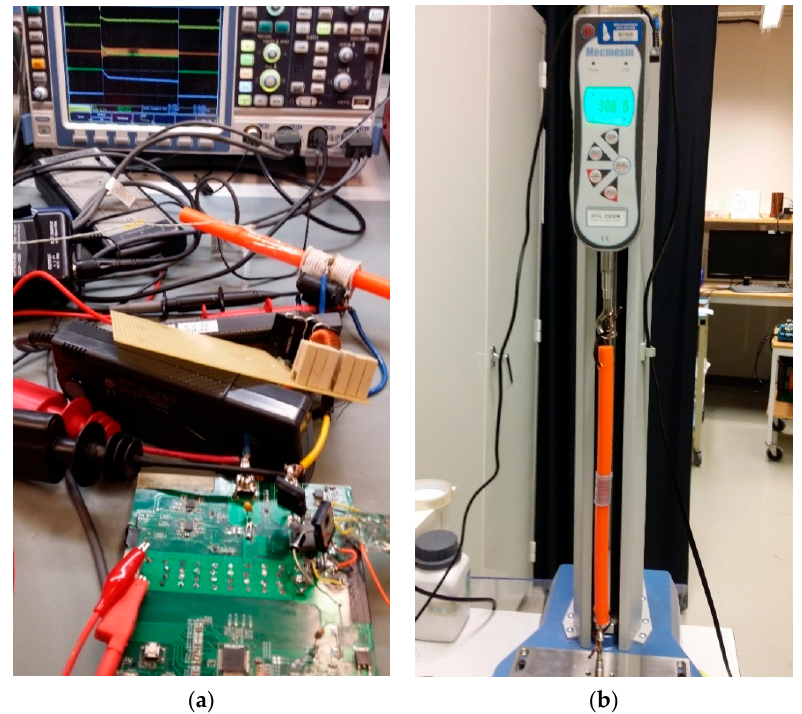
Figure 11. IOFEF joint welding sample: ( a ) Measurements during welding; ( b ) Pull strength test after welding.